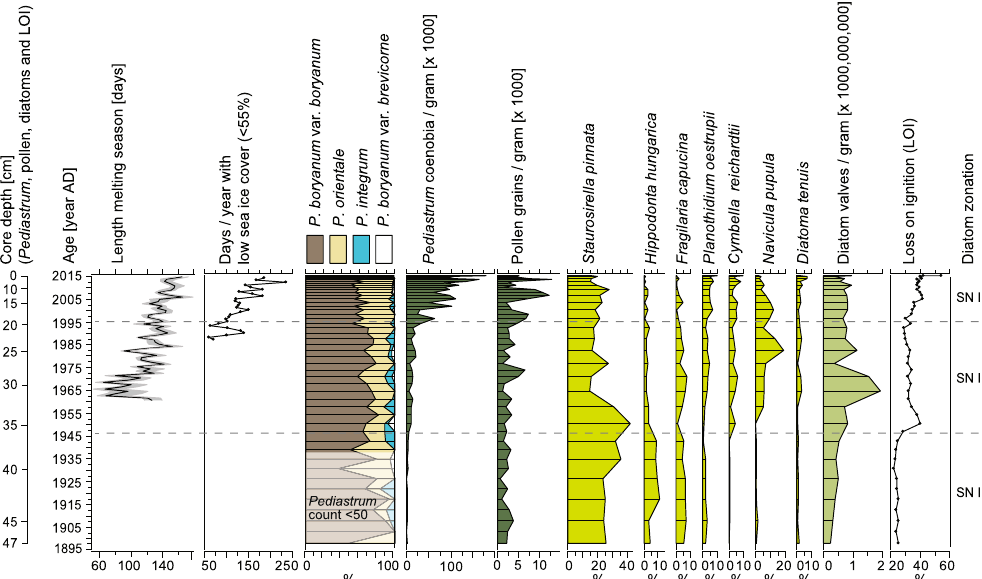
Figure 2. Synthesis of (approximate) melting season, sea ice cover near the studied site, and ecological data ( Pediastrum , pollen and diatom valve concentrations, Pediastrum and diatom percent relative abundance data, and LOI) as derived from the Andsjøen core sediments. See text and Methods for a more detailed description on how the age model and individual variables were derived. Note that the lowermost sediment samples contained low Pediastrum concentrations, resulting in < 50 Pediastrum coenobia per counted slide. This may have influenced the calculated Pediastrum percentages in this part of the